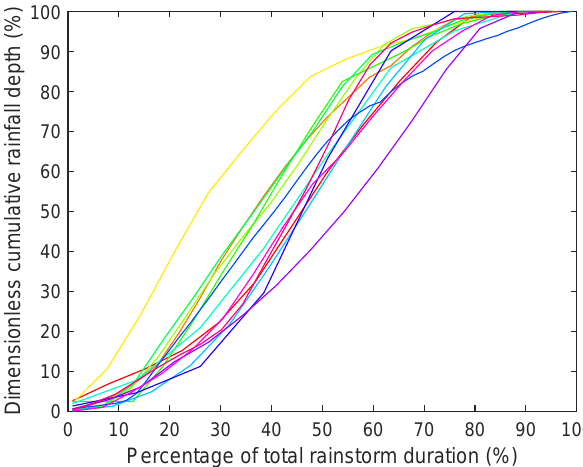
Figure 2. Dimensionless mass curve of 13 rainstorms selected in June, July and August of 2008 and